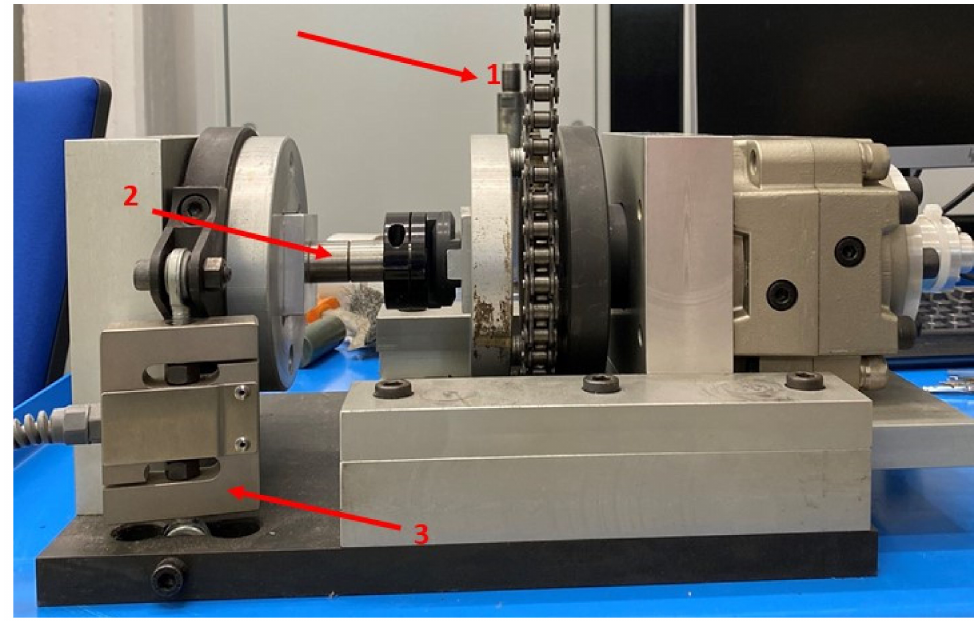
Figure 2. Torsion test apparatus.